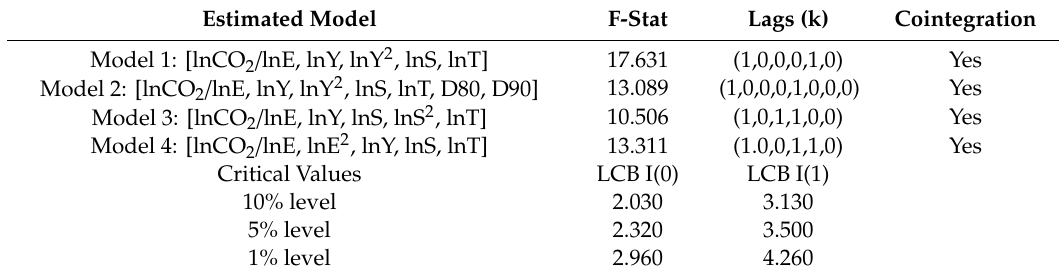
Table 6. Autoregressive distributive lag (ARDL) bound test for cointegrating relation. Estimated